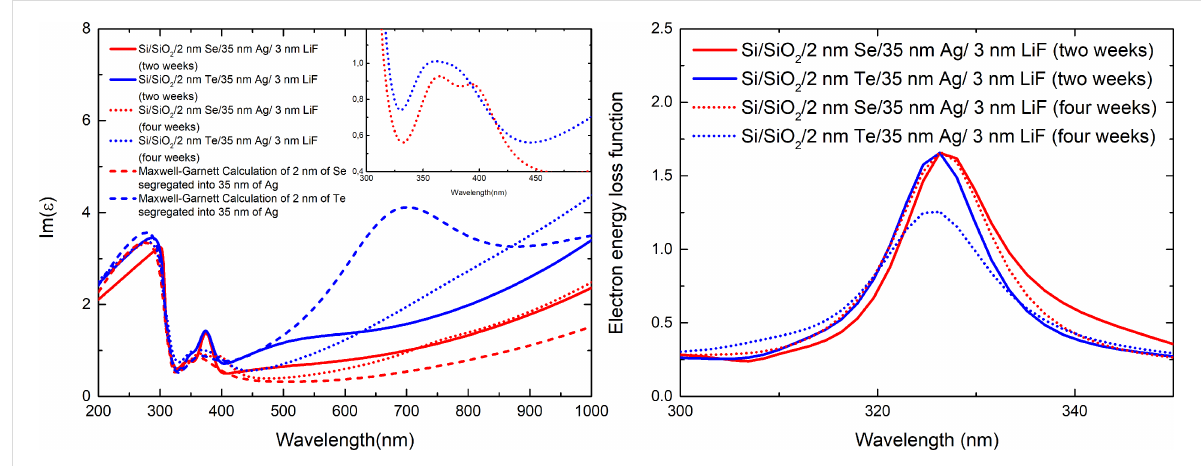
Figure 4: Left – Comparison of imaginary parts of the permittivity for 35 nm-thick Ag layers deposited on top of 2 nm-thick Se and Te films, measured either two or four weeks after deposition. Right – Electron energy loss function values for the same samples.